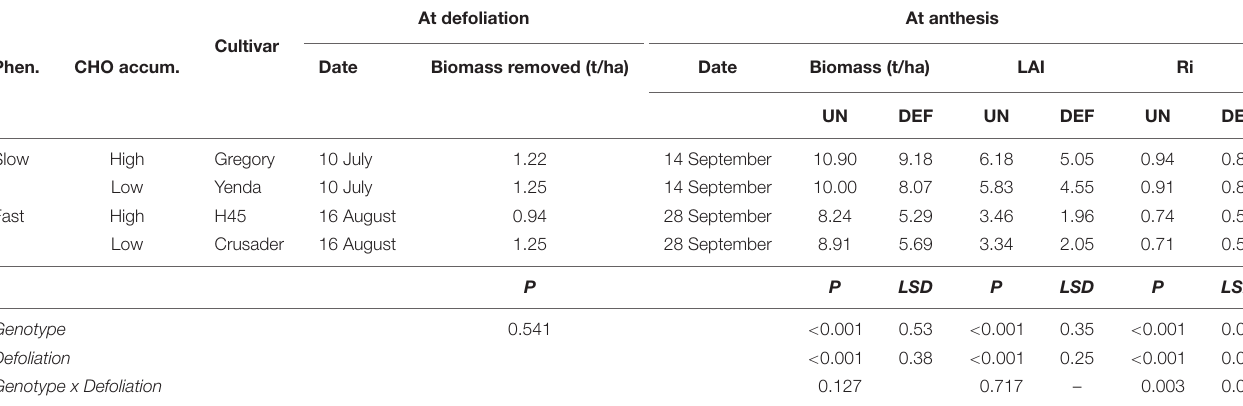
TABLE 4 | Biomass removed and subsequent biomass, leaf area index (LAI), and radiation interception ( R i ) at anthesis of four spring wheat cultivars following defoliation at GS30/31 (DEF) compared to an undefoliated control (UN) (Experiment 2 – Norwin, 2012). At defoliation At anthesis Cultivar Phen. CHO